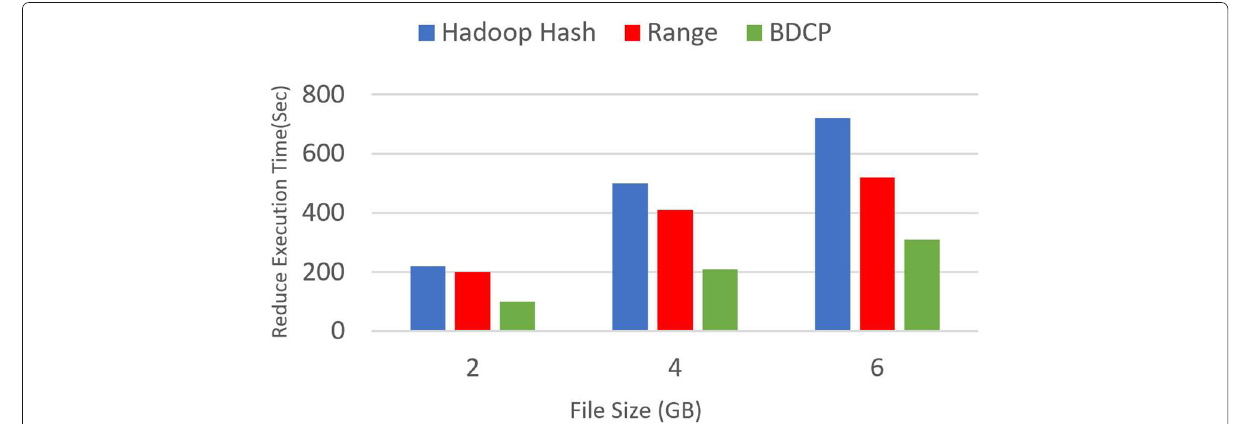
Fig. 12 Sort job on files of sizes, 2, 4, and 6 GB. Skew degree is 1.1